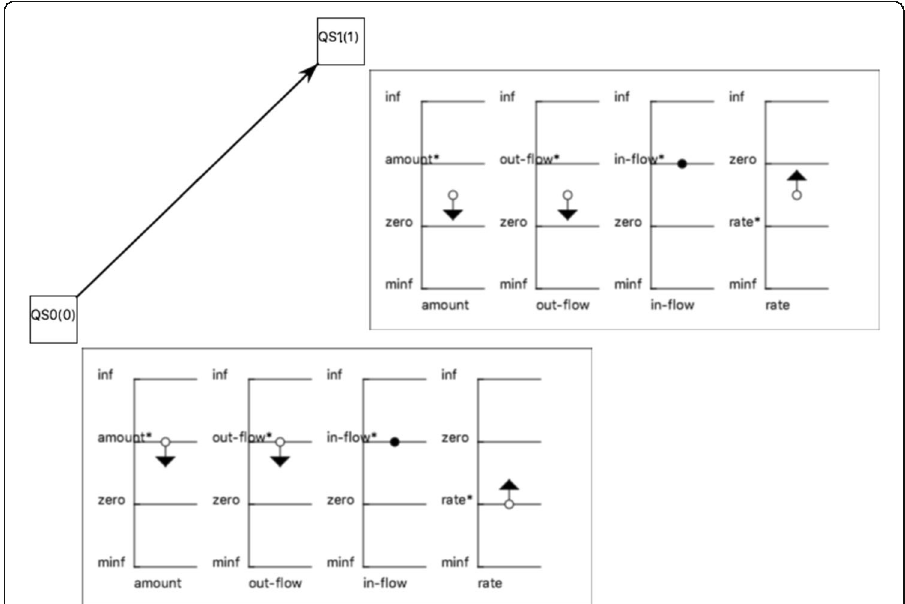
Fig. 2 Behavior of the bathtub model. This is one of the possible behaviors of the bathtub model in which the amount of water gradually decreases to become steady (i.e., input and output are in equilibrium). Behavior is represented as a sequence of qualitative states (each of which is a set of qualitative values of parameters of the system). When sufficient information is not provided for determining the unique behavior, all of the possible behaviors are enumerated because of ambiguity. In this example, depending on initial condition, the amount of water could gradually increase to become steady, or become almost